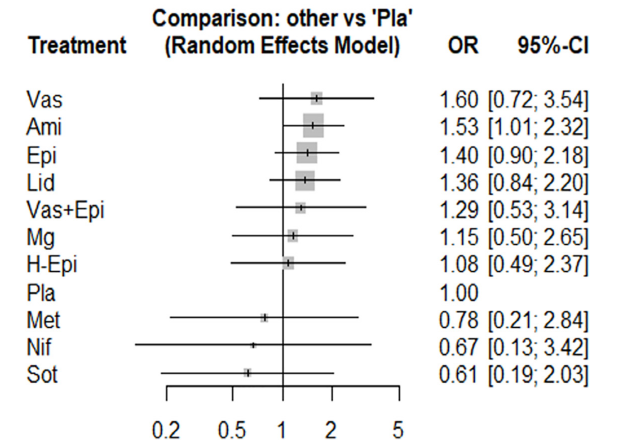
Figure 5. The forest plot of the network meta-analysis comparing the odds ratios on the survival to hospital admission among the medications. OR, odds ratio; CI, confidence interval; Ami, amiodarone; Epi, epinephrine; H-Epi, high-dose epinephrine; Lid, lidocaine; Met, methoxamine; Mg, magnesium sulfate; Nif, nifekalant; Pla, placebo; Sot, sotalol; Vas, vasopressin.